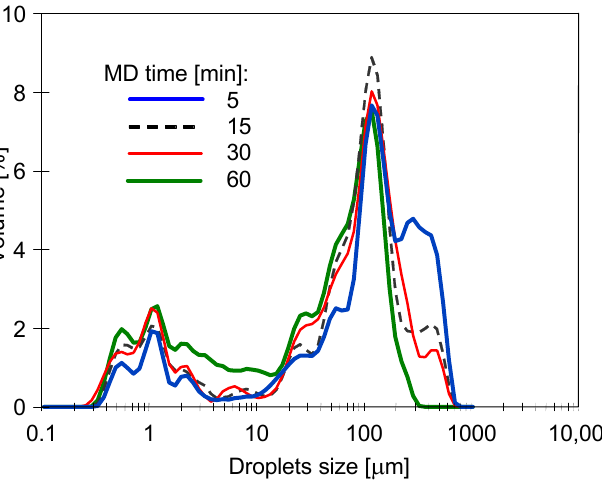
Figure 9. Changes in the droplet size distribution during the MD process. Feed: NaCl (200 g/L) + oil (85 mg/L) + oil (113 mg/L) + SDS (2 mg/L). Module: CMD.